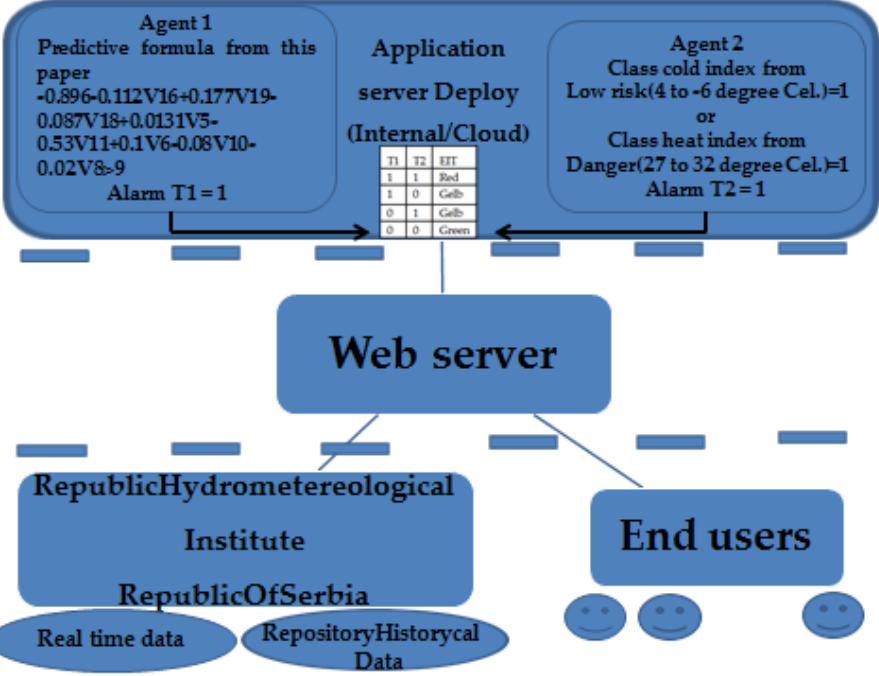
Figure 4. A technical solution that implements the proposed EIT model with two agents. A logical architecture of the implemented technical solution is shown in Figure 4. The decision agents are deployed on Applicative Server architecture that could be Dedicated Server or Cloud Server (AWS, MS Azure, Google Cloud, Oracle Cloud, etc). In our im- plementation solution, we have chosen Dedicated Server due to the requirement of the IT Administration Team from the local economic development office in the City of Nis, it is already described in this paper, in proposed solution are two agents T1 and T2